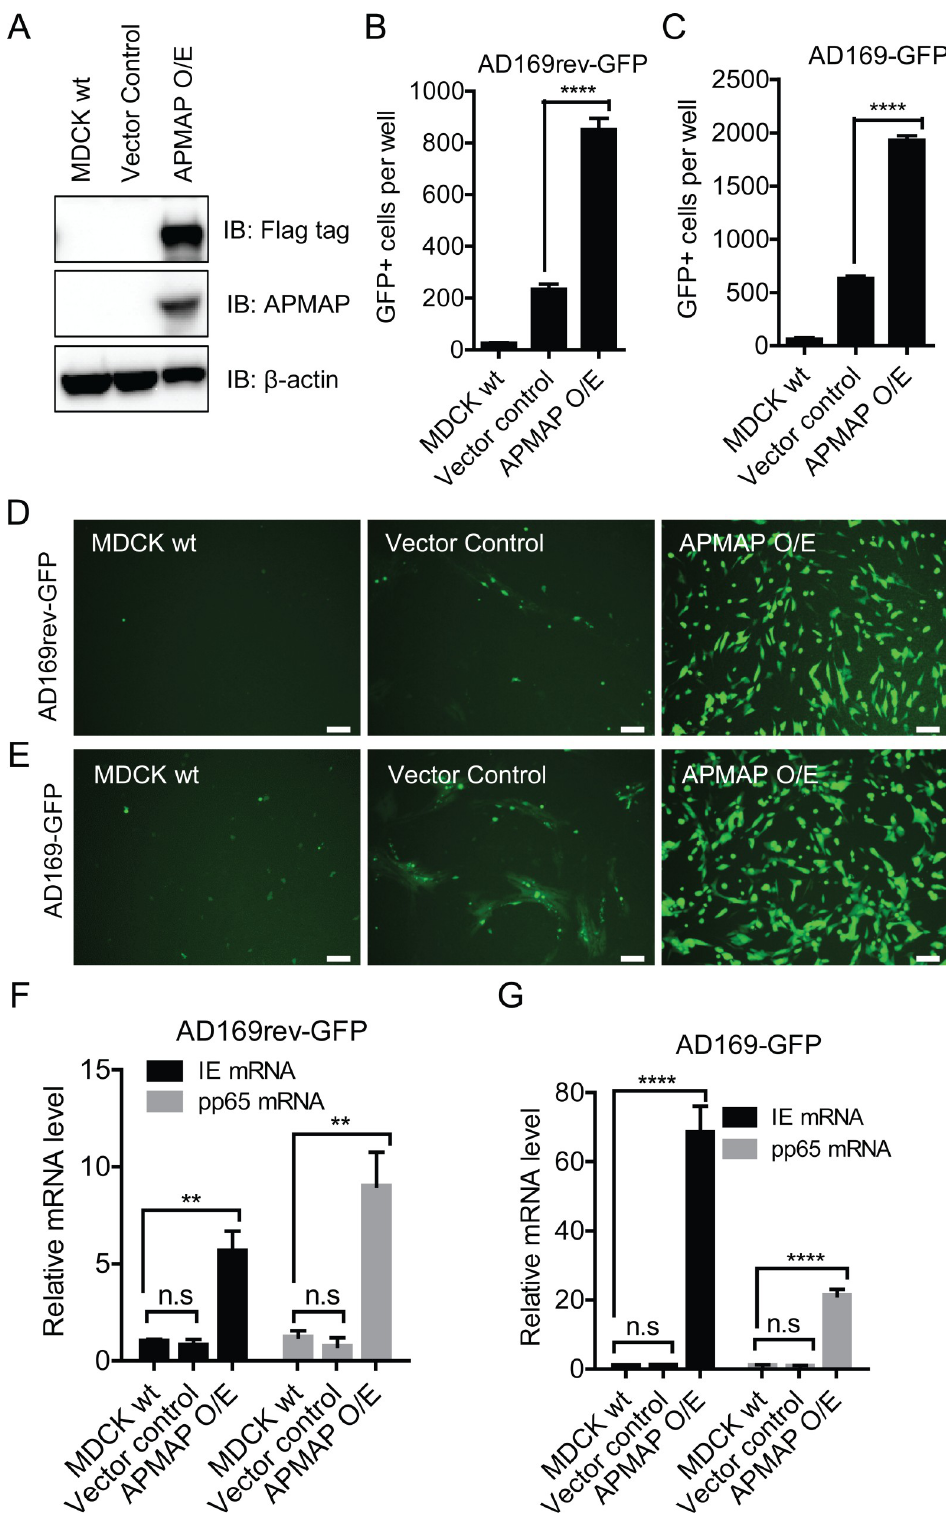
Fig 5. Expression of human APMAP permitted HCMV entry in MDCK cells. ( A ) APMAP O/E stable cells were established by infecting MDCK cells with lentivirus particles capable of expressing human full length APMAP coding sequence with a myc/flag tag at C-terminal under puromycin selection. APMAP over expression in MDCK cells were